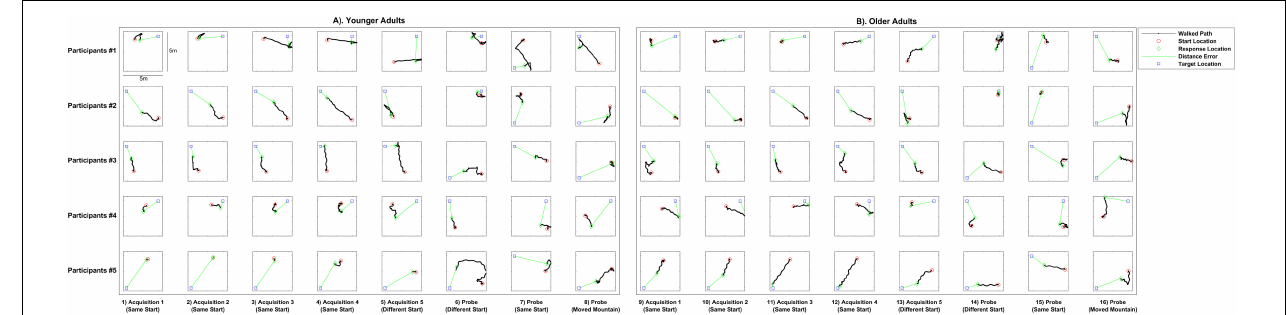
FIGURE 2 | Example paths walked by younger and older adults on individual trials. Columns 1–8 show younger adult paths, Columns 9–16 show older adult paths. Columns 1–4 and 9–12 show four trials of acquisition from the same starting point, columns 5 and 13 show an acquisition trial from a novel view point, and columns 6–8 and 14–16 show walked paths on three different types of probe trials: a new start location not seen during acquisition, a start location that was previously seen during acquisition, and one involving movement of a distal mountain. The red circles show where the participant started, the black lines show the path the participant walked, the green diamonds show where the participant made their response, and the blue squares show the target location. Green lines indicate the Euclidean distance from the response to target location, which correspond to the distance error shown in Figures 3–5 .